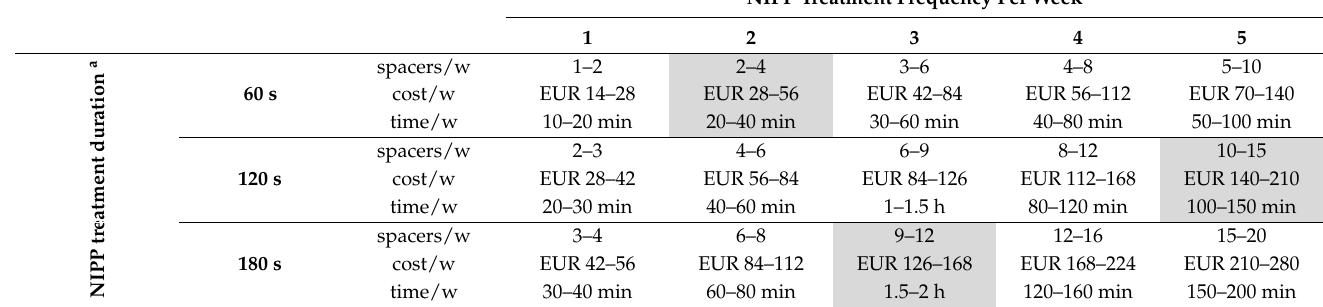
Table 4. Estimated weekly number of spacers, spacer cost, and additional treatment time (excluding possible waiting time and time needed to replace used spacers) for a mean breast surface area of 12 × 16 cm (i.e., 3 × 4 spacers). The grey areas indicate the three different treatment duration and frequency combinations that were explored in the current study. Cost and time estimates may vary depending on breast